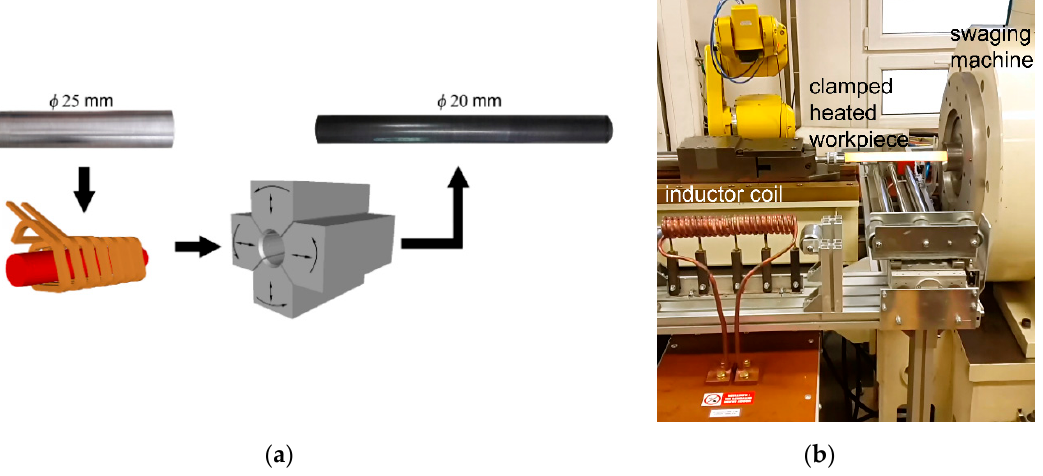
Figure 5. Schematics of induction heating and swaging process ( a ); photography of semi-automated laboratory manufacturing line with description of the main features ( b ).